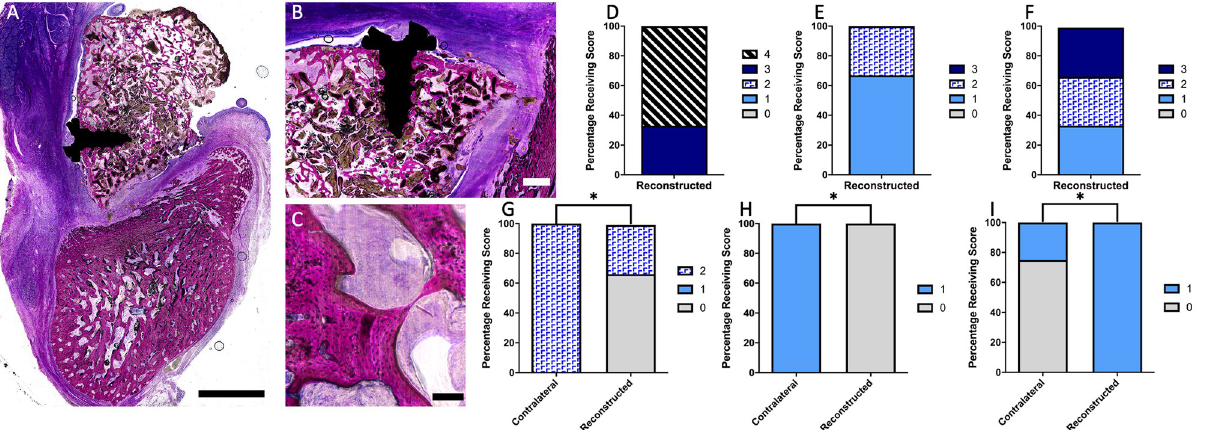
Fig 8. Histological analysis of mandibles. Low magnification (A) image of reconstructed mandible, with high magnification images showing clear signs of robust osseointegration of the screw (B) and viability of bony tissue (C). The graft coverage (D), integration of bony tissue with the adjacent native mandible (E), and screw osseointegration (F) are given for the n = 3 reconstructed mandibles. The mucosal intactness score (G), inflammatory cell presence (H), and periosteal reaction (I) scores are given for both the reconstructed (n = 3) and control (n = 4) mandibles. Scale bars: A = 5 mm, B = 1 mm, and C = 100 μ m. � indicates significant difference between the two groups (p <